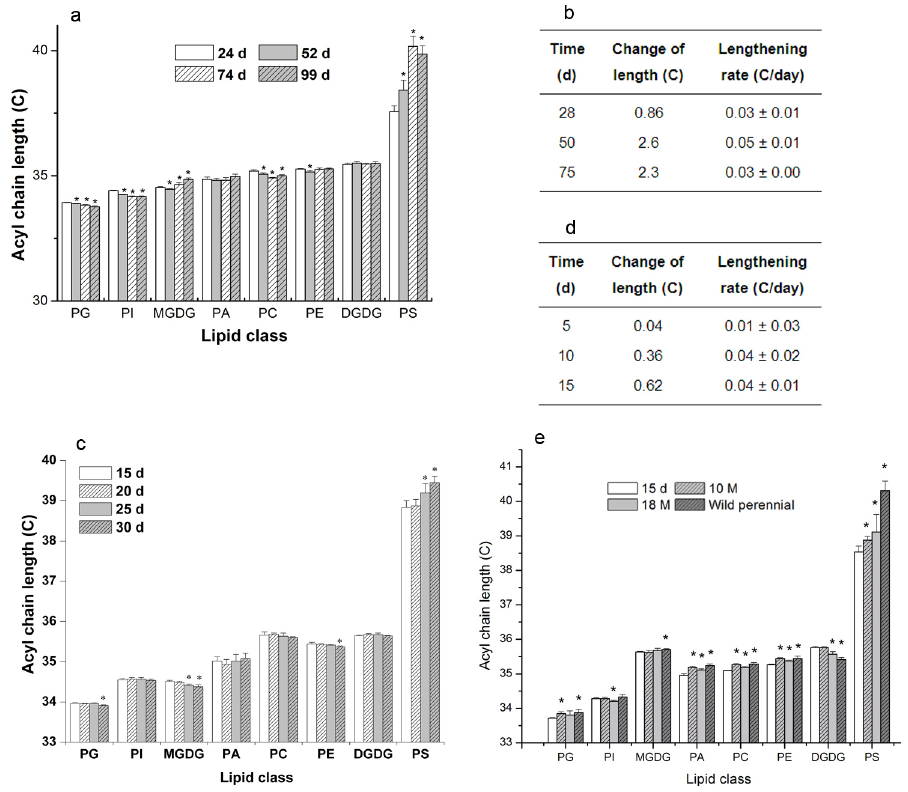
Figure 3. Acyl chains lengthen with plant development. ( a ) The acyl chain length of membrane glycerolipids during the development of leaves at 24, 52, 74 and 99 d in Arabidopsis , ( b ) The lengthening rate of acyl chains of PS during the development of leaves in Arabidopsis , ( c ) The acyl chain length of membrane glycerolipids during the development of siliques at 15, 20, 25 and 30 d in Arabidopsis , ( d ) The lengthening rate of acyl chains of PS during the development of siliques, ( e ) The acyl chain length of membrane glycerolipids during the development in roots of 15 day, 10 month, 18 month pot-grown, and wild perennial C. himalaica (W). Values are means 6 s.d. ( n =5). An asterisk indicates that the value is different from that of the earliest stage of the development detected ( p , 0.05